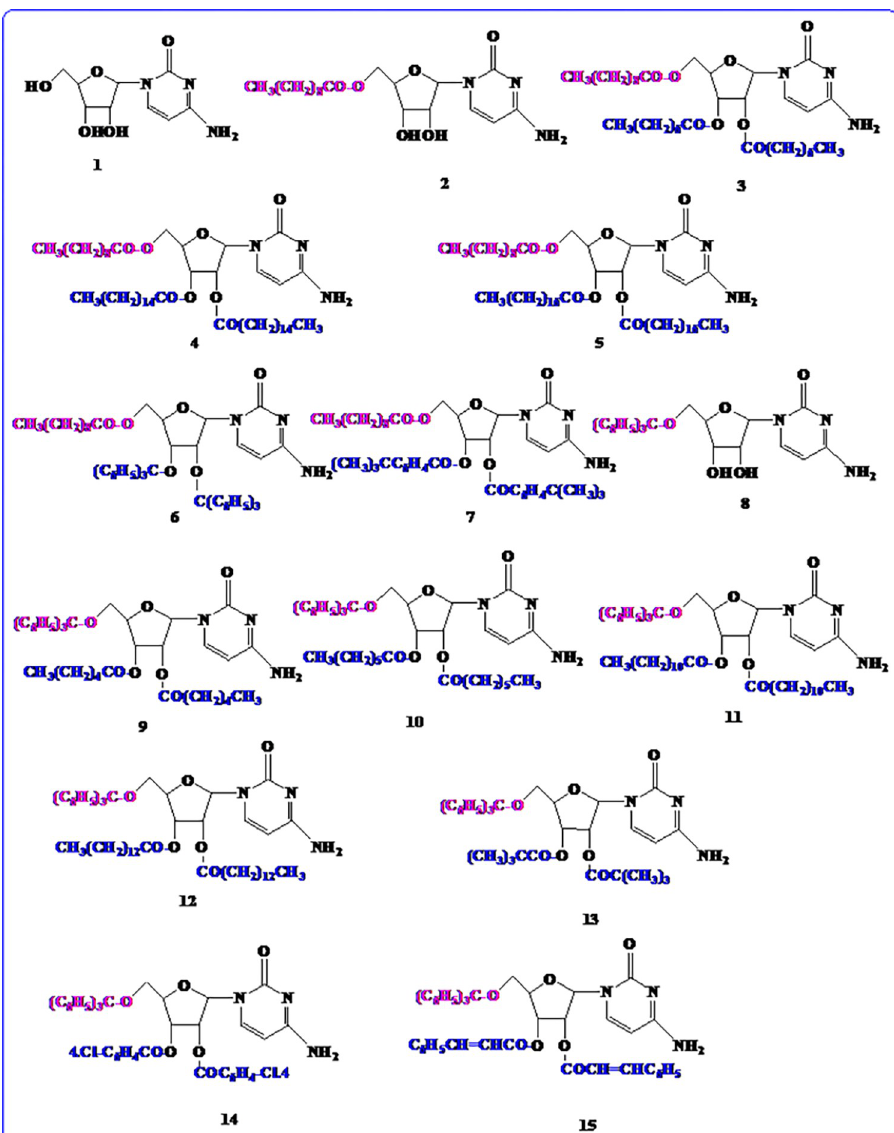
Fig 2. Structures. The designed cytidine ( 1 ) and its derivatives ( 2–15